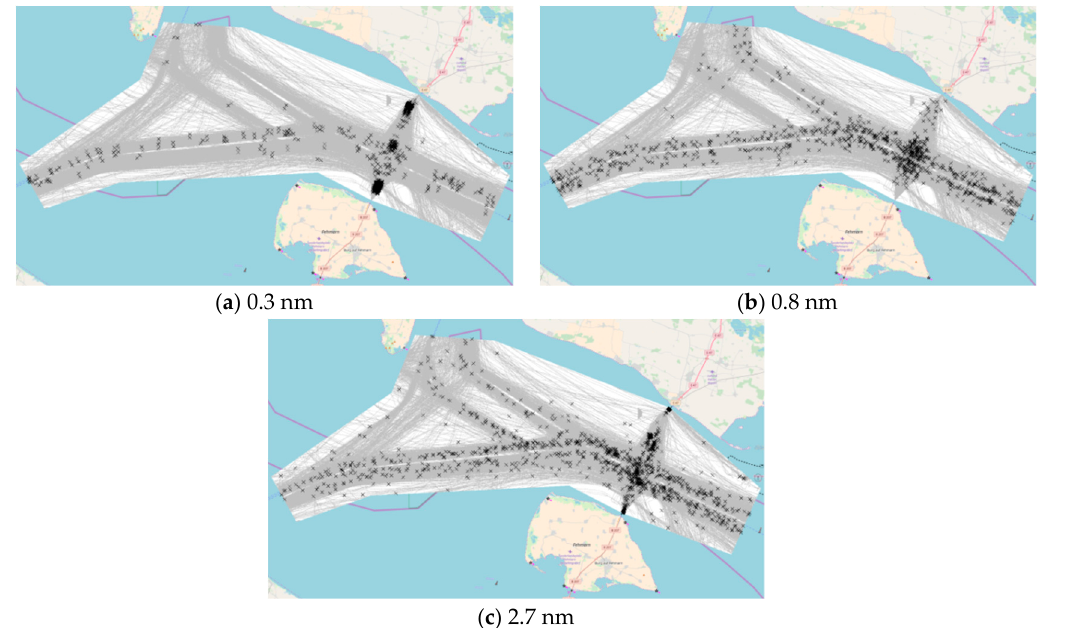
Figure 4. The positions of encounters (marked with x) between pairs of vessels at their closest point of approach: separated from each other by ( a ) 0.3 nm, ( b ) 0.8 nm, and ( c ) 2.7 nm.